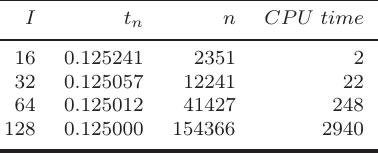
Table 5. The explicit Euler method for ε = 1 / 10000 .